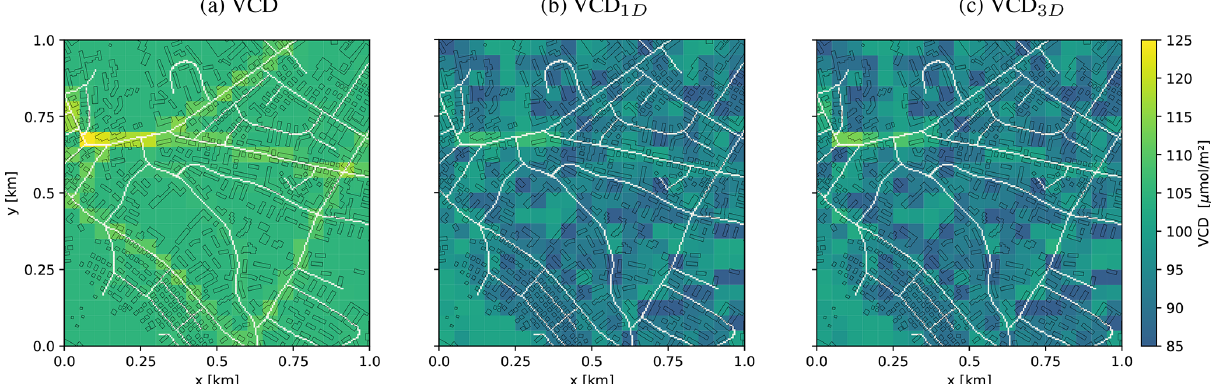
Figure 11. (a) True VCD field and VCDs computed from SCDs using 3D-box AMFs and buildings assuming (b) 1D-layer AMFs and (c) 3D- box AMFs without buildings. The scenario uses a SAA of 90 ◦